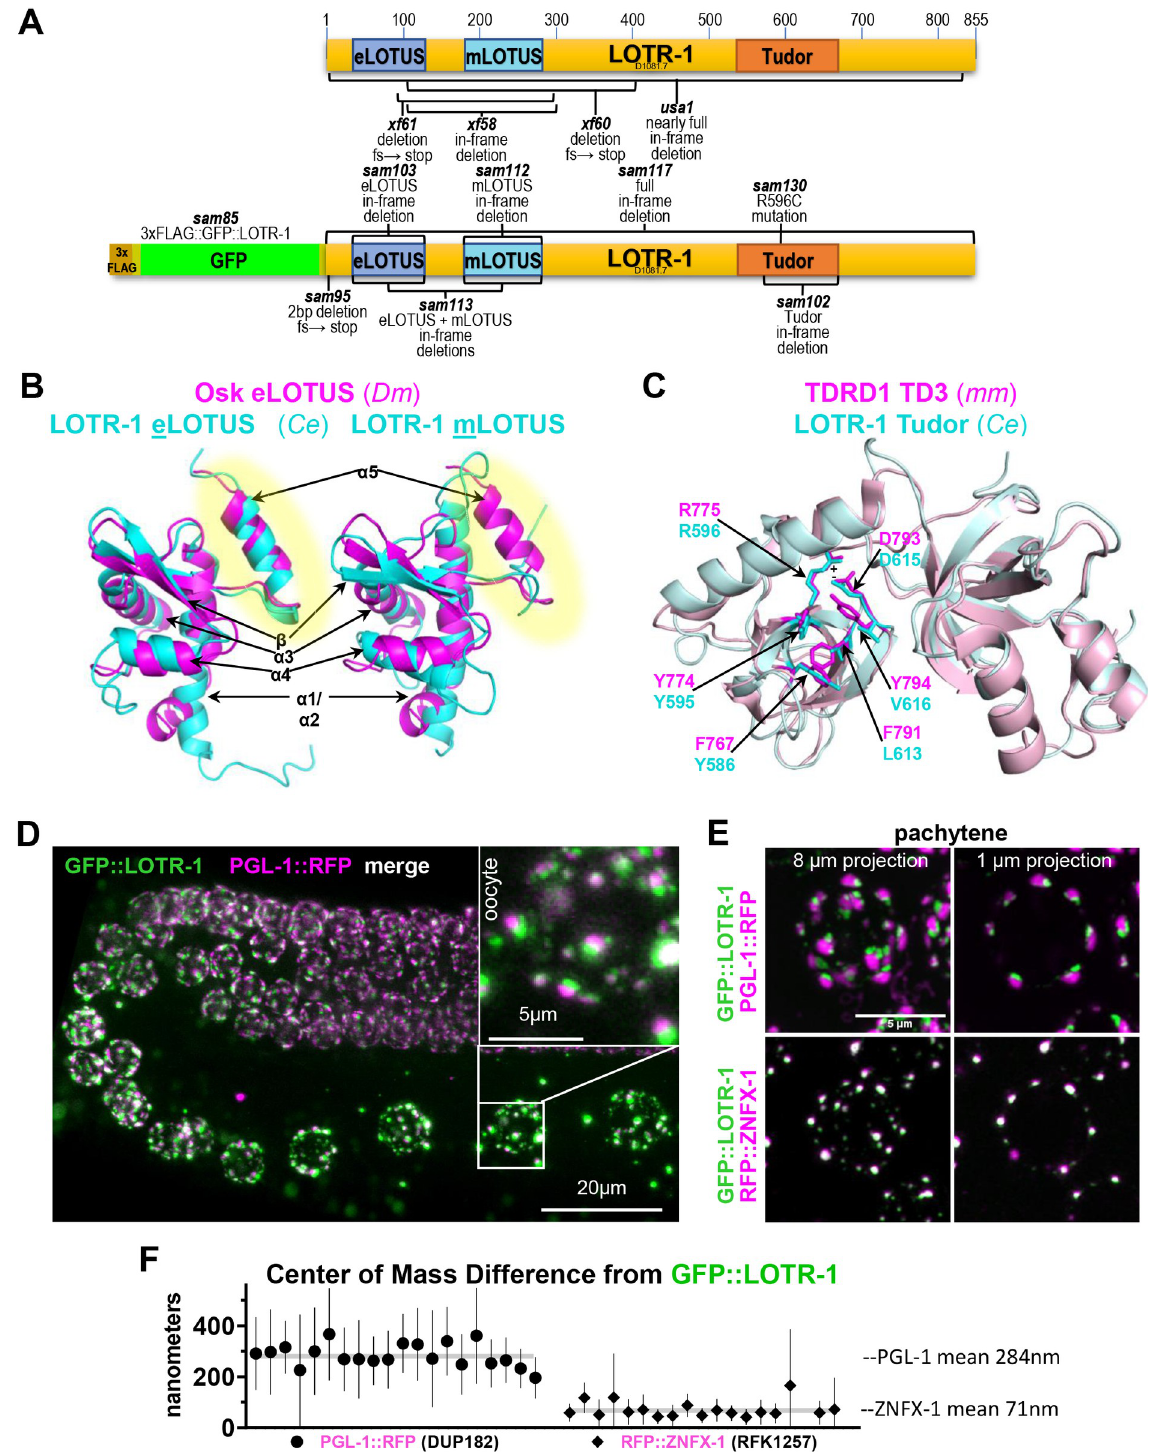
Fig 1. LOTR-1 contains both LOTUS and Tudor domains, and colocalizes with Z granules. A) Top schematic depicts the location of the eLOTUS, mLOTUS and Tudor domain of LOTR-1. Bottom depicts the CRISPR edit used to add an N terminal 3X FLAG tag and GFP. Alleles generated for this study are indicated. B) Predicted 3D model overlap of the eLOTUS and mLOTUS domains of C . elegans LOTR-1 with the Oskar eLOTUS domain from Drosophila melanogaster . The α 5 helix (highlighted) is only present in the eLOTUS domain. C) Predicted 3D structure of the Tudor domain (aa 534–670) of LOTR-1 overlapped with TD3 domain of mouse TDRD1. D) GFP::LOTR-1 and PGL-1::RFP in